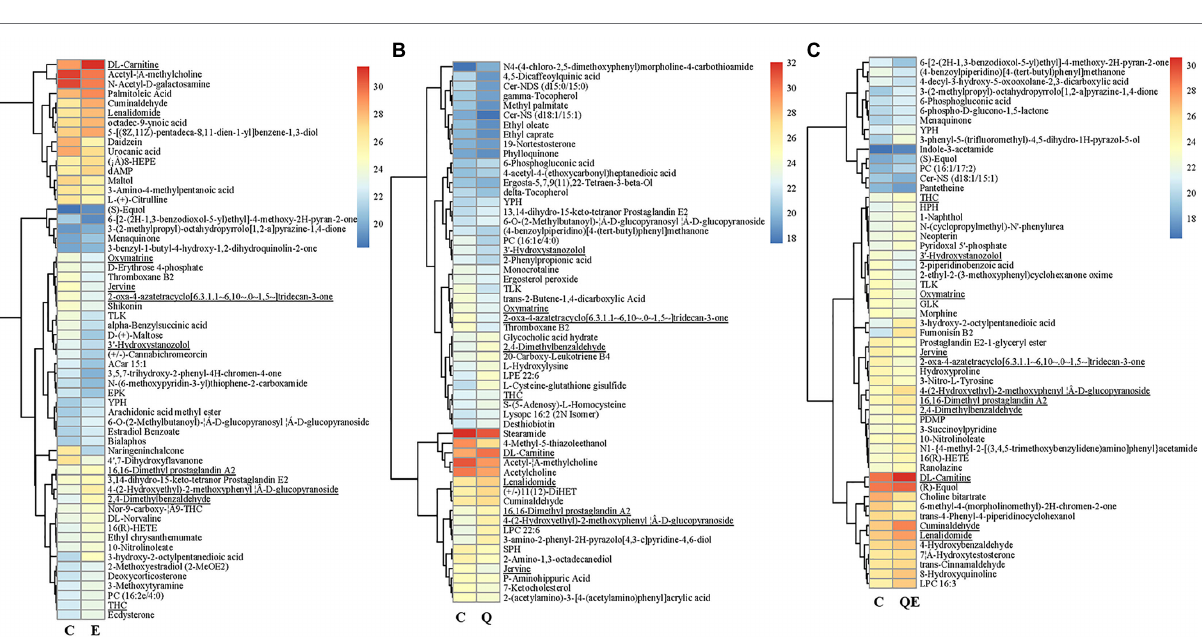
FIGURE 6 | Heatmap clustering of differentially accumulated metabolites (DAMs) and their transformed ion intensities (log2) detected in the cecum of the aged breeder chickens fed with quercetin (Q), vitamin E (E), or QE compared with the control group in pairwise comparison (C). (A) E_vs_C. b. Q_vs_C. c. QE_vs_C. The partial least square discriminant analysis of log2 fold change ≥ 1 and variable importance in projection ≥ 1 were used to screen for DAMs. The underline compounds in (A–C) represent those detected concurrently among the three pairwise groups. Deoxyadenosine monophosphate